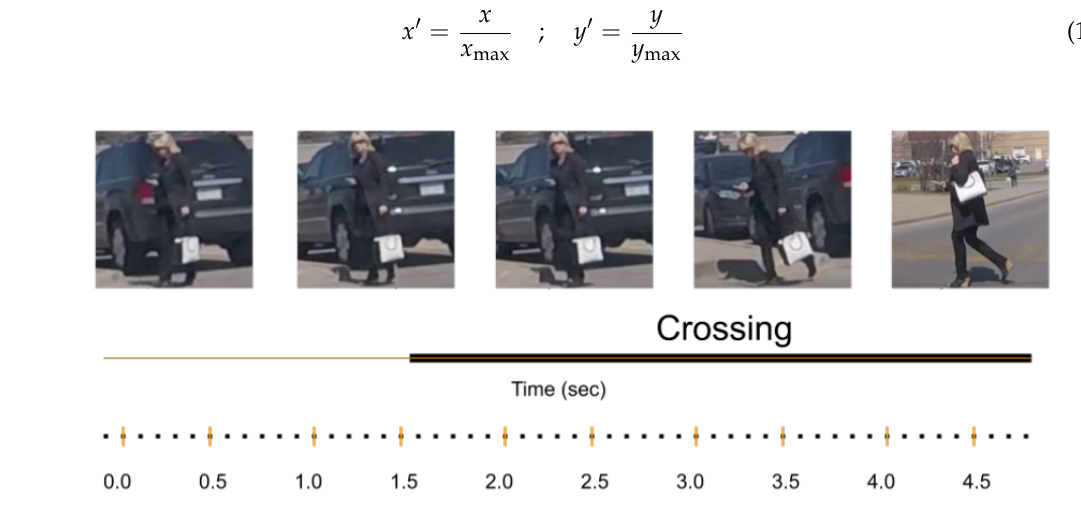
Figure 3. Time line of a crossing pedestrian in the Joint Attention in Autonomous Driving (JAAD) data